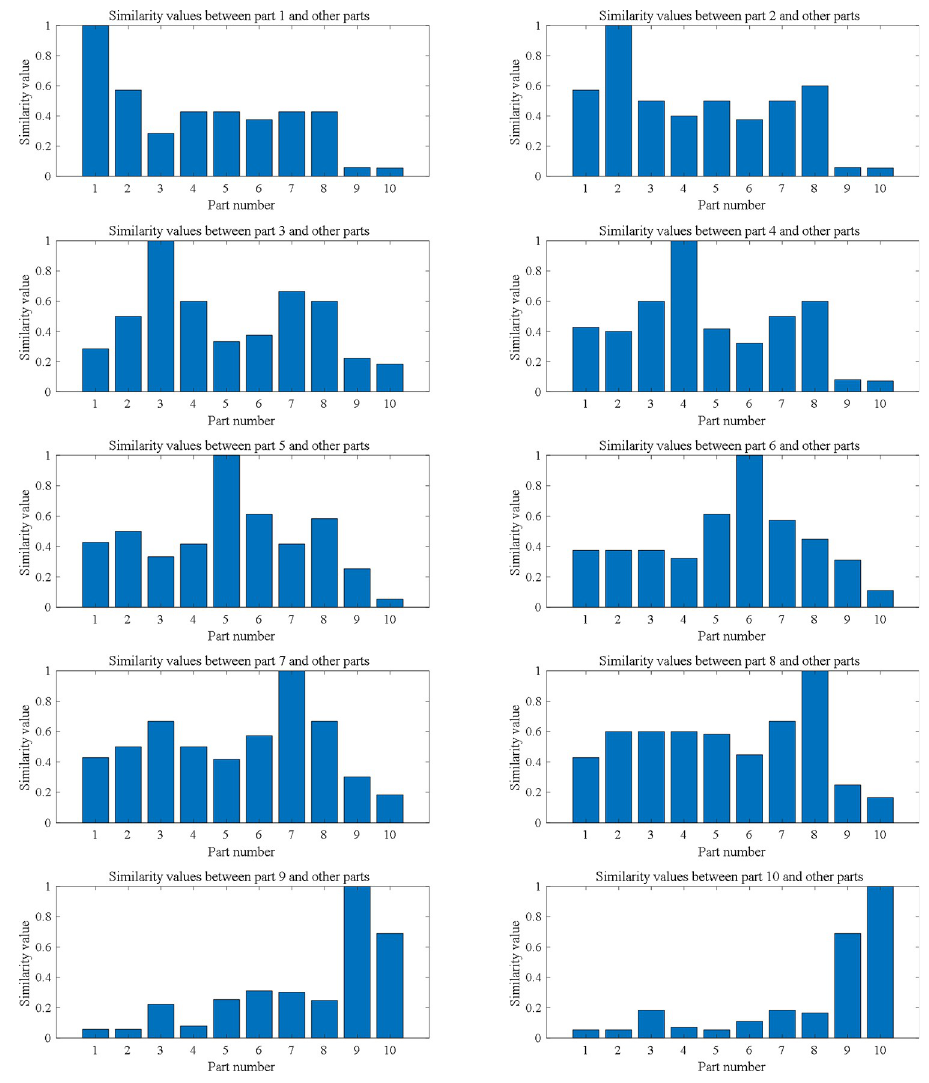
Fig 3. Similarity calculation results of process